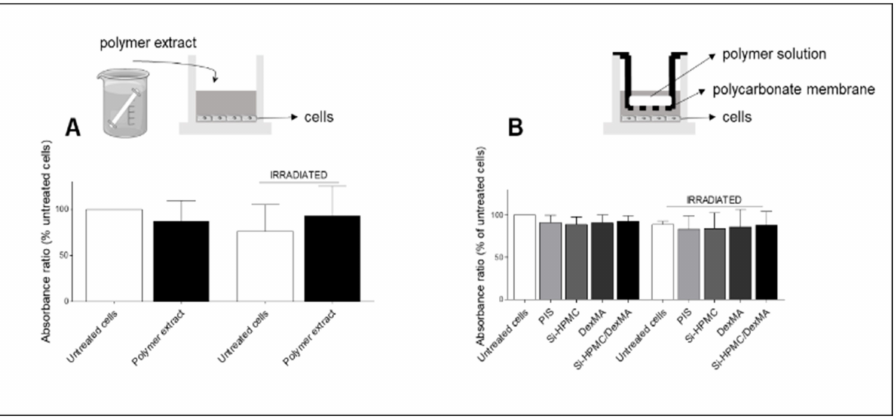
Figure 5. Cytocompatibility assessed via neutral red uptake by L929 cells seeded at 16,000/cm 2 after ( A ) 24 h in the presence of DexMA polymer extract, ( B ) 24 h in the presence of 5 µ L/mL of PIS and Si-HPMC, DexMA, or Si-HPMC/DexMA. In order to examine the effect of irradiation, the solutions were exposed to visible light from a lamp for 120 s. The results are presented as means ± SEM ( n = 3) and analyzed using two-way ANOVA with the Bonferroni post hoc test. Si- HPMC: silanized hydroxypropyl methylcellulose, DexMA: dextran methacrylate, Si-HPMC/DexMA: silanized hydroxypropyl methylcellulose/dextran methacrylate, PIS: photoinitiator